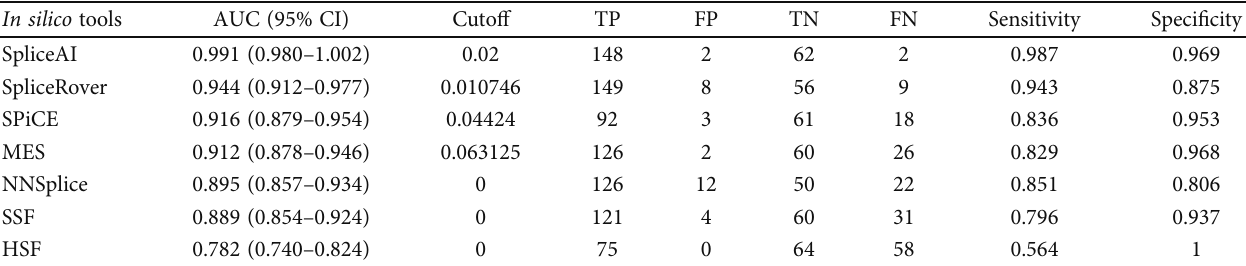
Table 1: Summary of evaluation measures for 7 in silico tools for all splice sites.